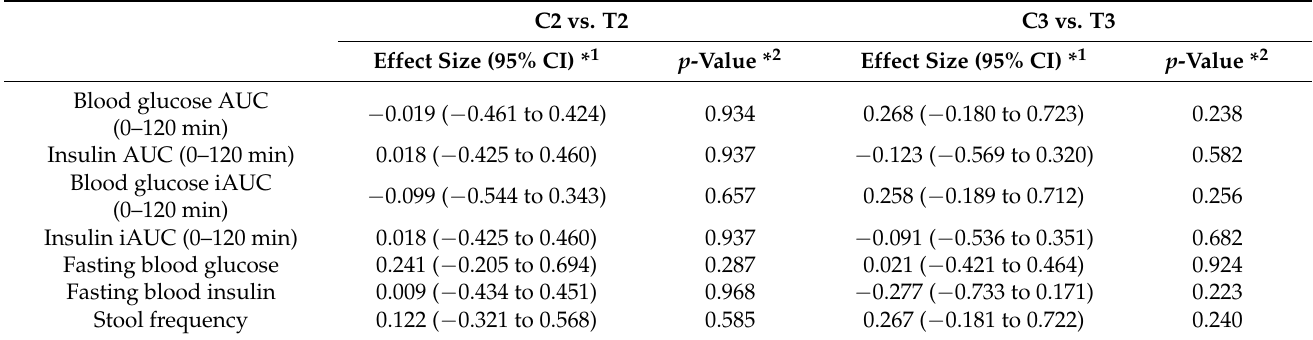
Figure 1. Overview of the double-blind randomized crossover trial ( A ) Flow diagram of this trial. ( B ) Outline figure of this trial. Two 4-week dietary treatments were set in succession. The dietary intervention periods were interspaced by a 4-week washout period. Blood and stool samples were collected before and after 2 and 4 weeks of each intervention period. ( C , D ) Scatter plots showing results of multidimensional scaling using beta diversity (unweighted UniFrac distance) calculated from microbiome profile. Plots were color-coded by subject ( C ) or time point ( D ). ( E , F ) Scatter plots showing the results of multidimensional scaling using beta diversity (Spearman correlation distance) calculated from metabolome profile. Plots were color-coded by subject ( E ) or time point ( F ). Table 1. Effect size and p -values of primary and secondary